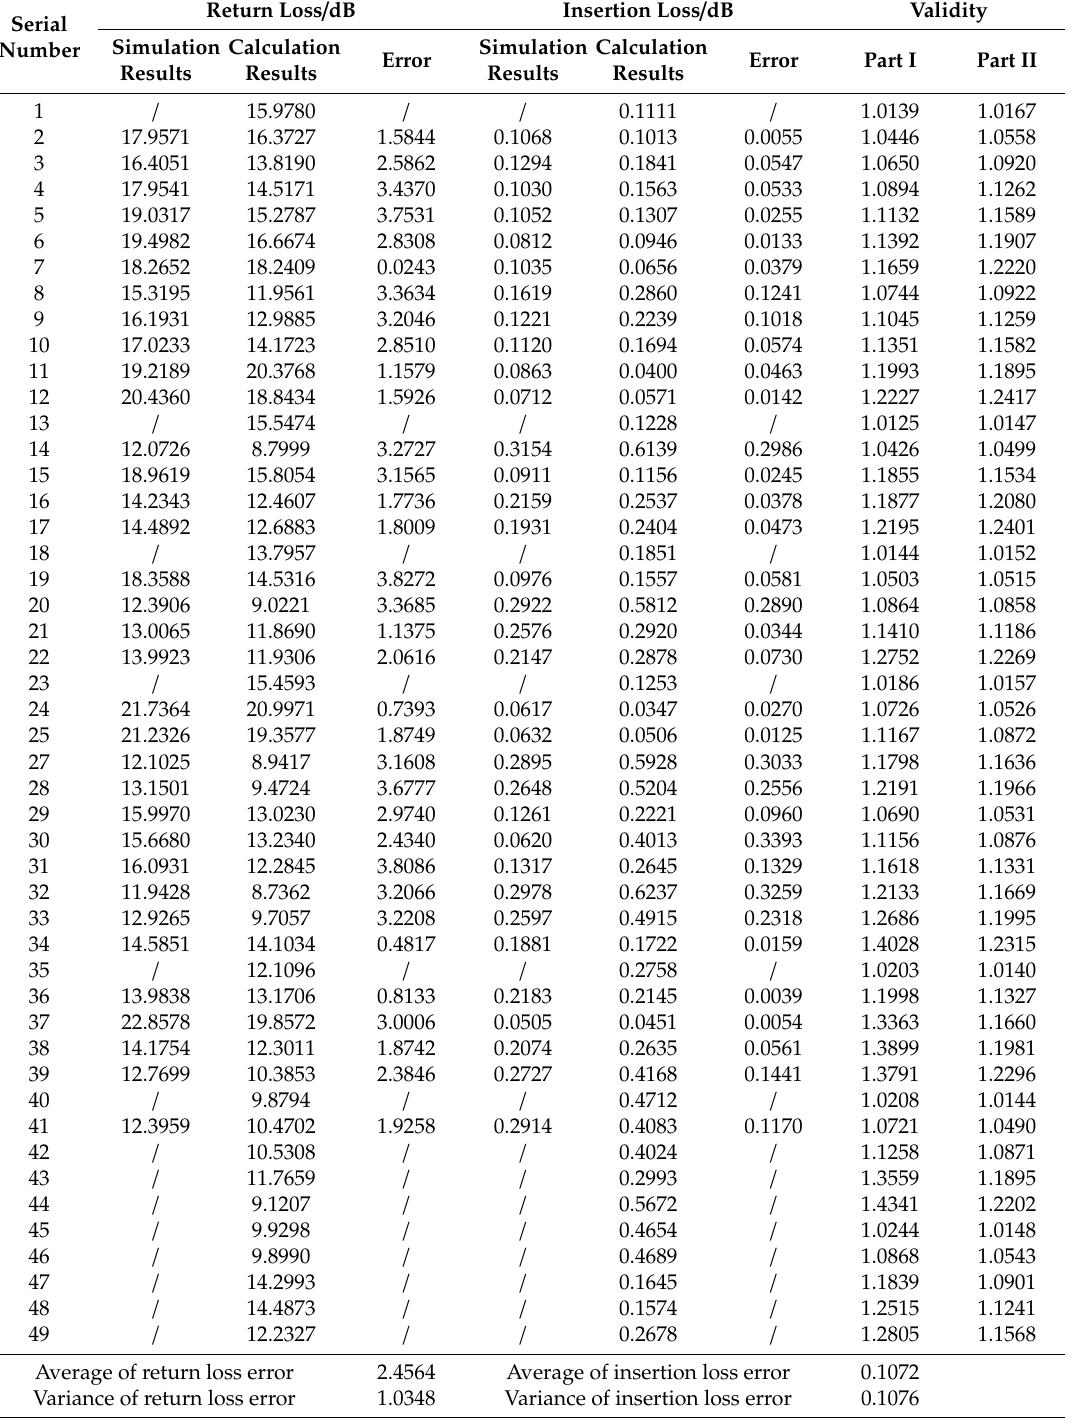
Table A4. Accuracy verification at 10